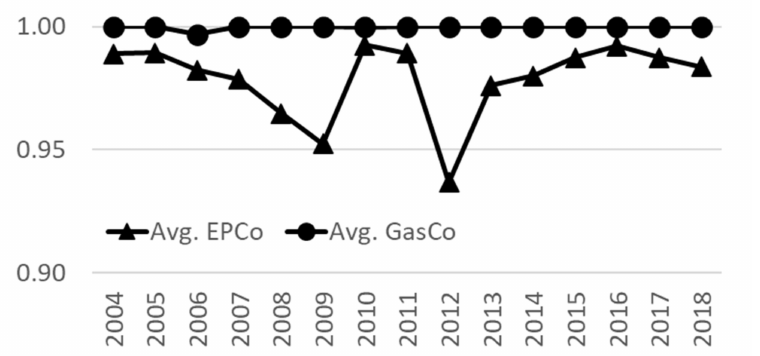
Figure 4. Operational Efficiency (WOE) of Utility Companies: Window Analysis. Note: See the bottom of Tables 2 and 3. Table 4 summarizes the window-based operational index ( WOI c